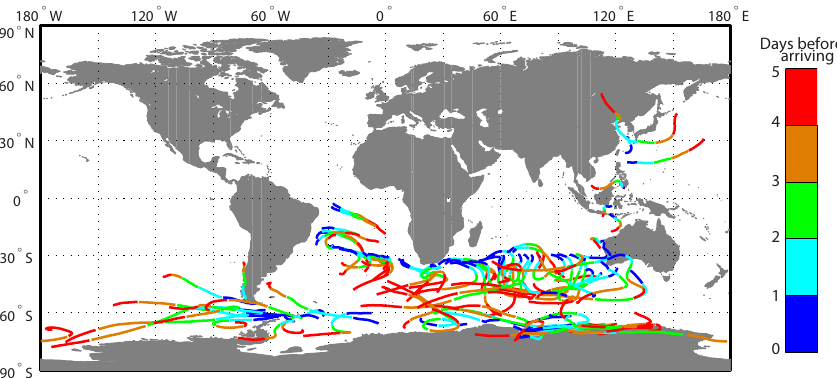
Figure 1. Five-day back trajectories calculated from the HYSPLIT model for all sampling locations. Blue indicates the ending point of each back